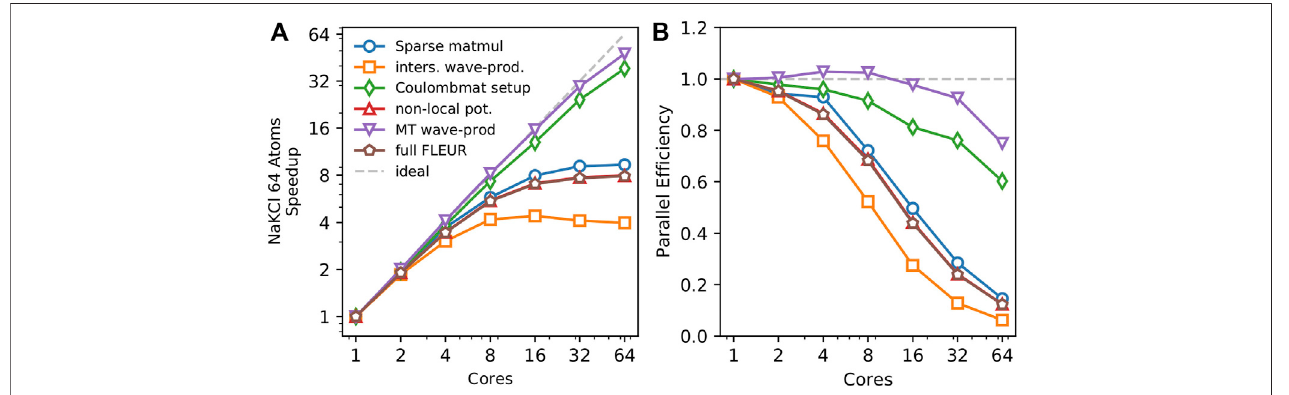
FIGURE 1 | Strong scaling behavior with OpenMP on a single AMD EPYC 7742 64 core processor. The overall FLEUR iteration is shown with brown pentagons, whilethecalculationofthenonlocalpotentialisshown inredtriangles.Thefourremaininglinesshowthemajorpartsofthenonlocalpotential.Theredtrianglesindicating the nonlocal potentiallargely coincide with thebrown pentagons indicatingthe fullruntime, making itdif fi culttosee them. Theparallelef fi ciency ofslightlyabove 100 % in the routine forthesetupmixed-product basisfor4and 8nodes isexplained bycache effects.Dependingon thenumber ofcoresused thestride oftheparallelized loops executed on each core is changed, which can reduce the number of cache misses if this stride coincides with certain array dimensions.